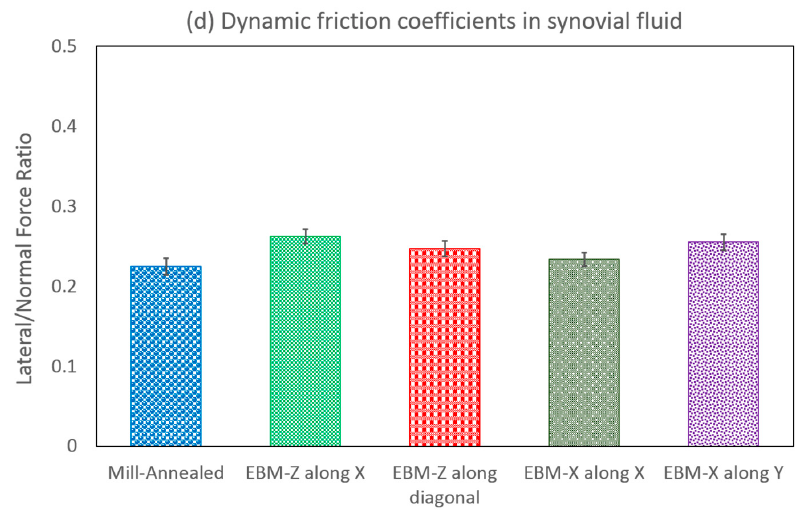
Figure 10. Evolution of friction coefficients: ( a ) Measured friction coefficients during dry sliding contact; ( b ) averaged friction coefficients in ambient; ( c ) averaged friction coefficients in PBS; ( d ) averaged friction coefficients in simulated synovial fluid.